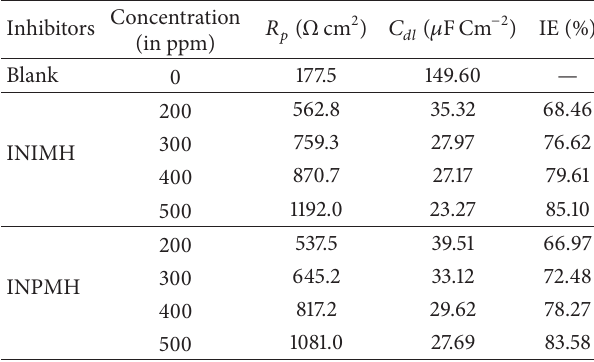
Table 5: Impedance parameters for corrosion of MS in 0.5 M HCl in the absence and presence of different concentrations of INIMH and INPMH at 30 ∘